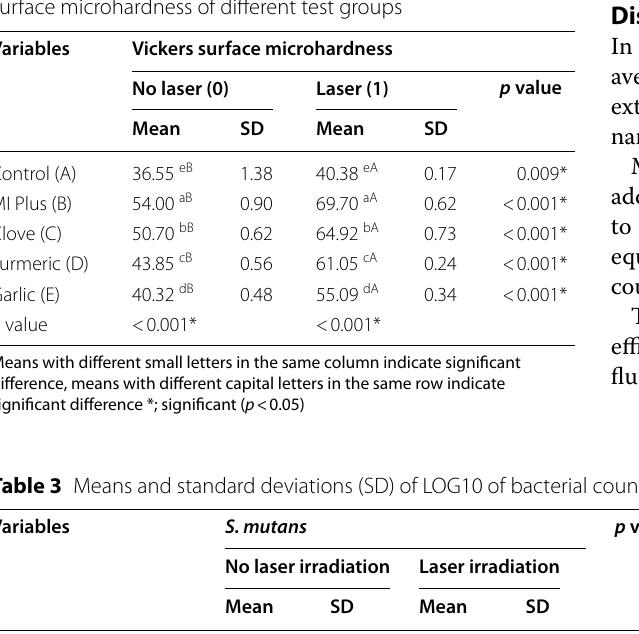
Table 2 The mean, standard deviation (SD) values of Vickers surface microhardness of different test groups